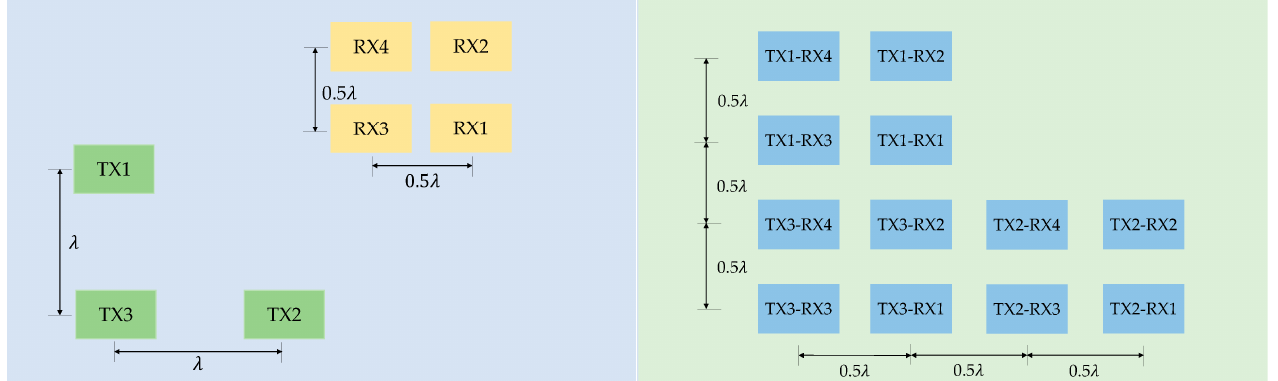
Figure 3. Actual antenna array layout ( left ) and virtual antenna array layout ( right ). The virtual array layout describes the virtual channels made by different combinations of transmitting and receiving antennas. Reprinted/adapted with permission from Ref. [23]. 2022, Texas Instruments.